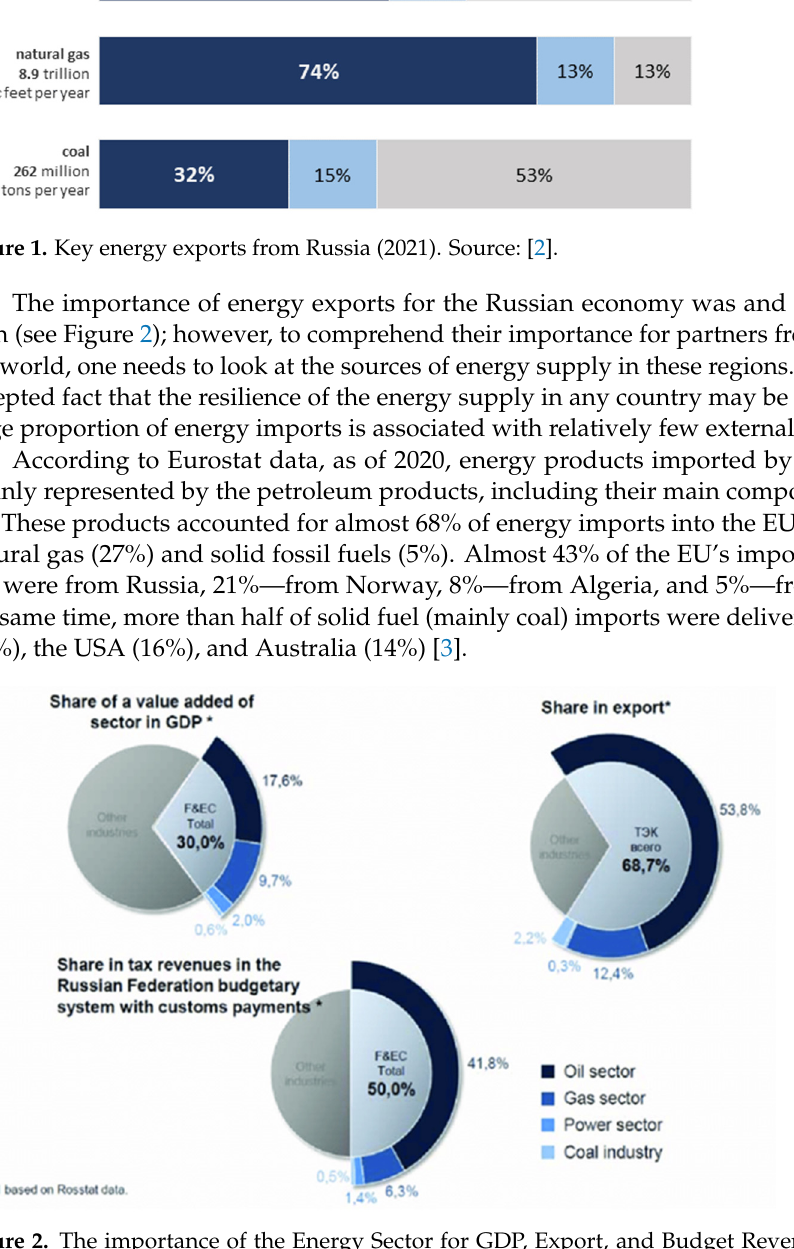
Figure 2. The importance of the Energy Sector for GDP, Export, and Budget Revenues of Russia. Source: [4].